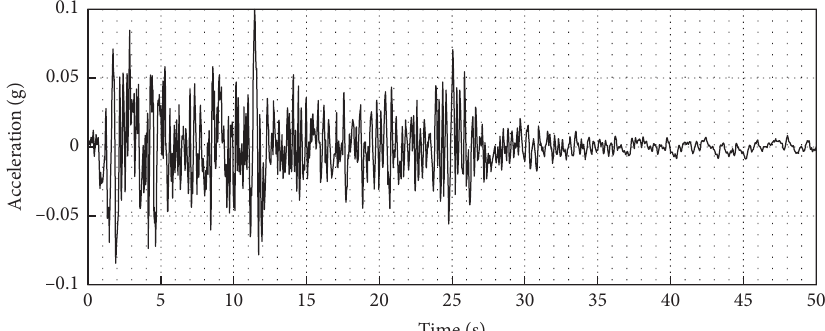
Figure 4: Time history of an El Centro seismic wave input into the shaking table (acceleration � 0.1